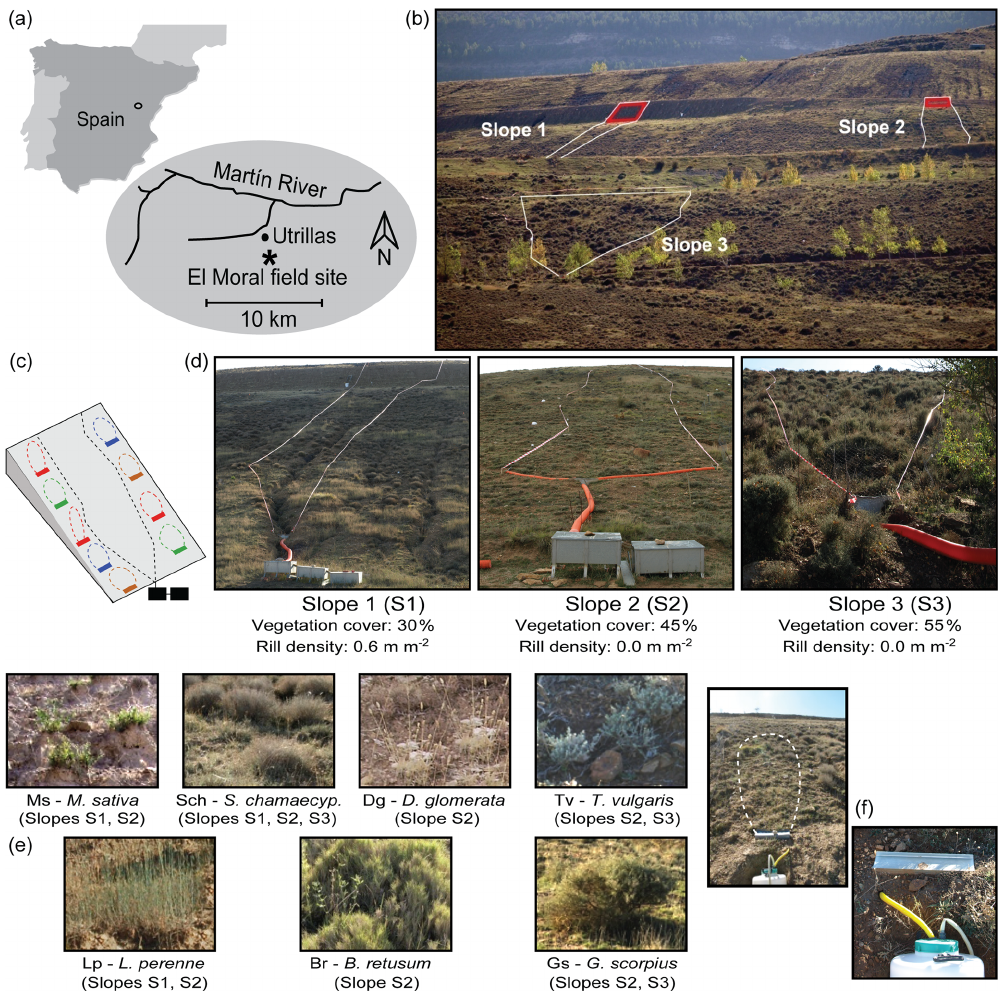
Figure 1. The Utrillas field site: (a) location map; (b) frontal view of the three experimental slopes (40 ◦ steep, berm sections located at the top of Slope 1 and Slope 2 are highlighted in red); (c) schematic representation of the experimental layout in the slopes (a hierarchical, scaled approach with patch-scale and hillslope-scale runoff and erosion plots); (d) frontal view of the hillslope-scale plots (catchment plots) and their general characteristics (vegetation cover and rill density); (e) detailed view of the seven surface types (vegetation communities) identified in the experimental slopes by Merino-Martín et al. (2012a); (f) an example of patch-size plot showing a small detail (right picture) of the Gerlach trough runoff and sediment collection systems. Names of the dominant plant species for the surface types: Ms, Medicago sativa ; Sch, Santolina chamaecyparissus ; Dg, Dactylis glomerata ; Tv, Thymus vulgaris ; Lp, Lolium perenne ; Br, Brachypodium retusum ; and Gs, Genista scorpius